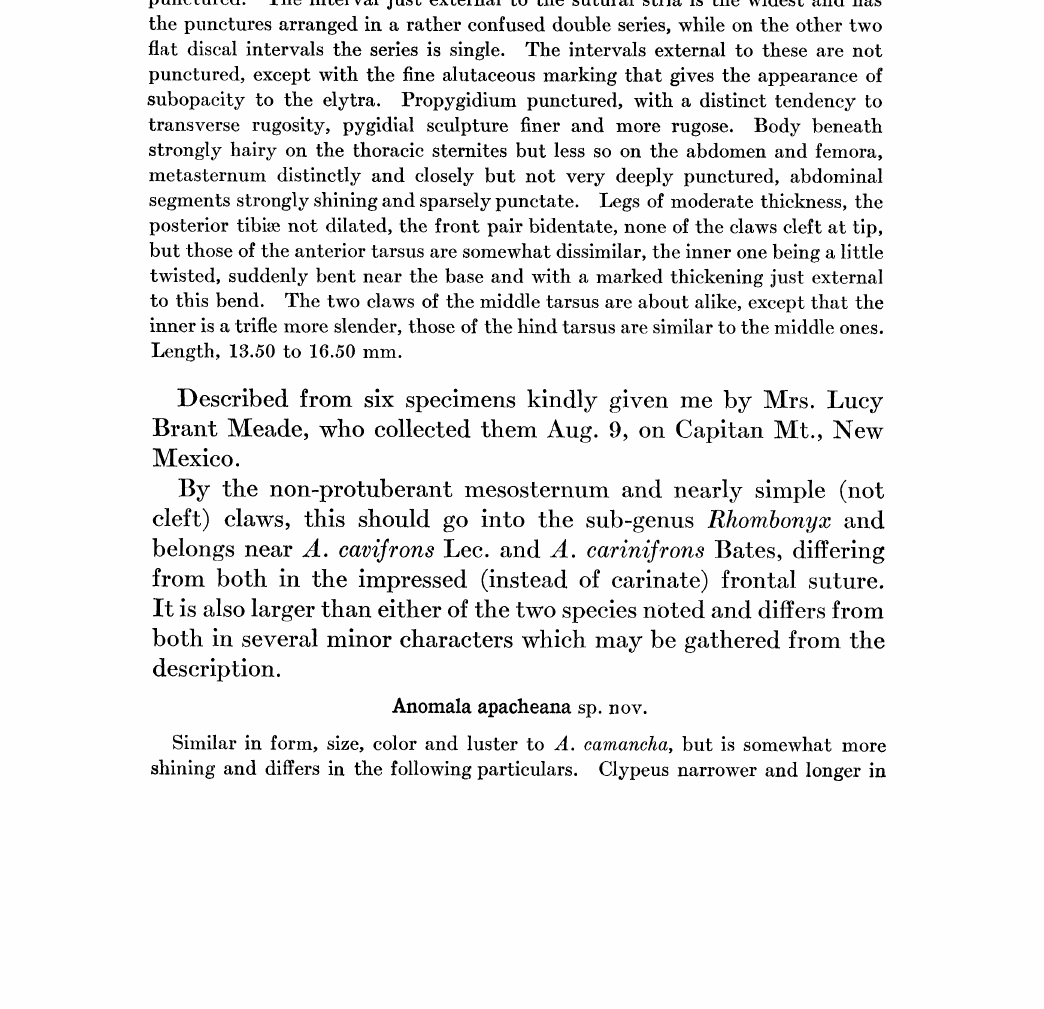
eyes black. Head of normal size, front rather coarsely, densely, and more or less confluently but not deeply punctured, the vertex much less closely. Clypeus punctured similarly to the front but a little less strongly, the front edge nearly straight, angles broadly and evenly rounded, sides subparallel or slightly convergent posteriorly for about the basal half of the length, margin entire, somewhat strongly reflexed, frontal suture deeply impressed and about straight, Antennal club about equal in length to all of the remaining joints. Pronotum with an antemedian, shallow, dark-colored fovea each side, marginal bead strong all the way around, basal lobe barely visibly emarginate or sinuate at middle, the pronotal disk punc- tured, rather sparsely over most of the surface but more closely at sides, the punc- tuation fine, the intervening spaces alutaceous. Scutellum punctured similarly to the pronotum. Elytra a little more shining than the prothorax, distinctly and rather strongly striate, the strim punctured weakly on the disk, a little more strongly at the sides and near the base, the intervals of the dorsum distinctly alternating in height and breadth, the broader ones lower than the others and rather sharply punctured. The interval just external to the sutural stria is the widest and has the punctures arranged in a rather confused double series, while on the other two flat discal intervals the series is single. The intervals external to these are not punctured, except with the fine alutaceous marking that gives the appearance of subopacity to the elytra. Propygidium punctured, with a distinct tendency to transverse rugosity, pygidial sculpture finer and more rugose. Body beneath strongly hairy on the thoracic sternites but less so on the abdomen and femora, metasternum distinctly and closely but not very deeply punctured, abdominal segments strongly shining and sparsely punctate. Legs of moderate thickness, the posterior tibim not dilated, the front pair bidentate, none of the claws cleft at tip, but those of the anterior tarsus are somewhat dissimilar, the inner one being a little twisted, suddenly bent near the base and with a marked thickening just external to this bend. The two claws of the middle tarsus are about alike, except that the inner is a trifle more slender, those of the hind tarsus are similar to the middle ones. Length, 13.50 to 16.50